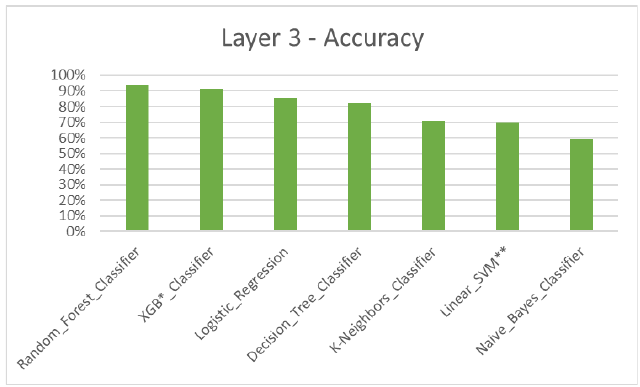
Figure 6. Layer 3 for prediction of growth modulation, camouflage and jaw surgery treatment options for jaw base III — accuracy. * XGB — eXtreme Gradient Boosting. ** SVM — Support Vector Ma- chine. Table 7. Layer 4 — accuracy.